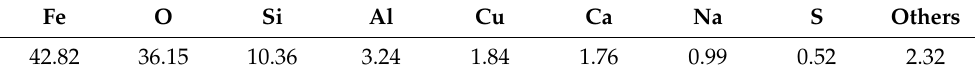
Table 2. Elemental analysis of the copper slag (wt. %) determined by X-ray fluorescence.